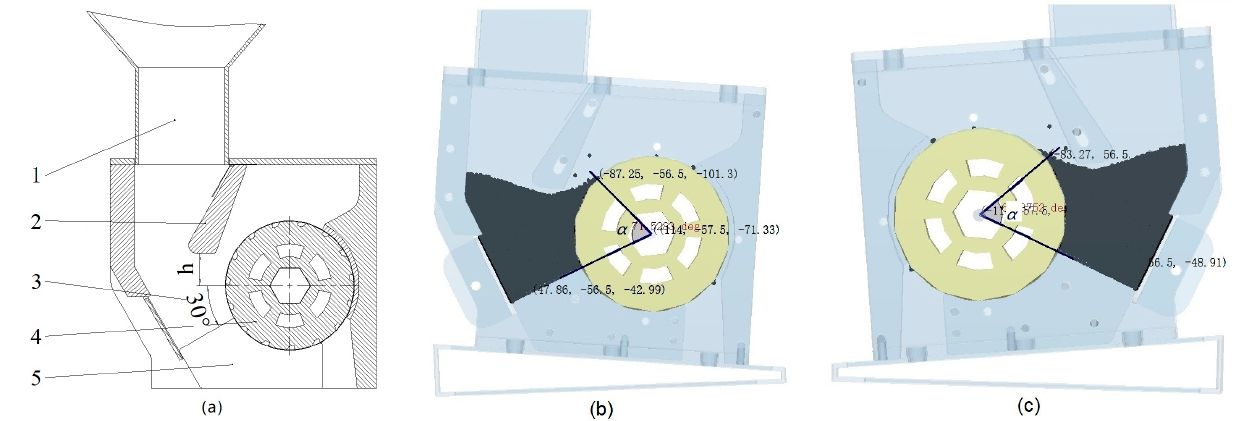
Figure 4. Structure of the centralized seed-metering device ( a ), seed-filling angle in left side view ( b ), and seed-filling angle in right side view ( c ). Note: (1) seed hopper, (2) seed layer adjusting plate, (3) seed chamber, (4) seed-metering mechanism, (5) shell. Note that α was the seed-filling angle.